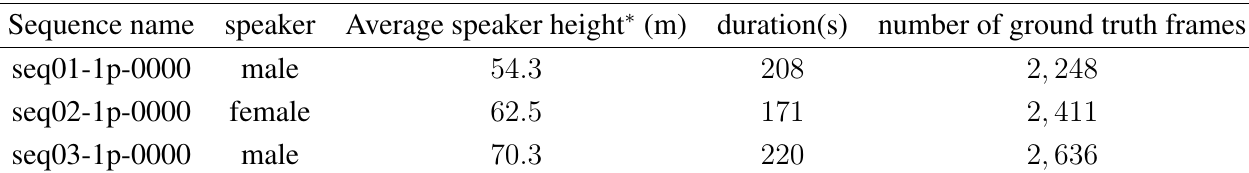
Table 1. Characteristics of the audio sequences used in the experimental